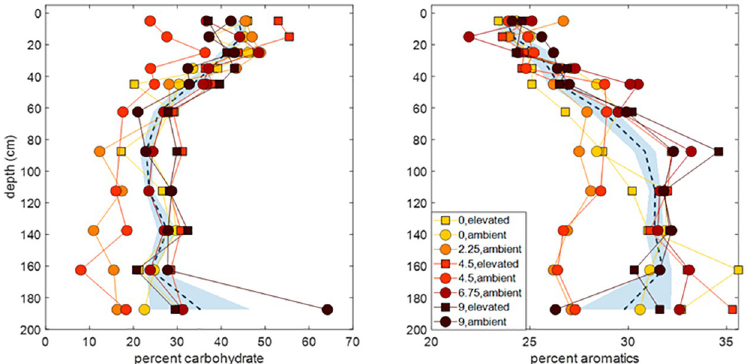
Fig 2. Organic matter composition. Percent carbohydrate and aromatic content in samples compared from each temperature treatment in 2019 compared to the 2014 pre-heating values, circles indicate ambient CO 2 and squares indicate elevated CO 2 treatments. Dashed lines indicate the locally weighted polynomial regression (LOESS) of the pre-heating (2014) values across all enclosures with the ± 95% confidence interval indicated by the blue shaded area around each line (MATLAB 2020a). Results for 2019 are plotted as individual symbols for each temperature treatment as indicated in the legend. Panel A. Carbohydrate content decreased from surface to -70cm, where carbohydrate content stabilized or slightly increased. Panel B. Aromatic content in samples increased with depth, with no discernable difference between pre-heating and five-years into the